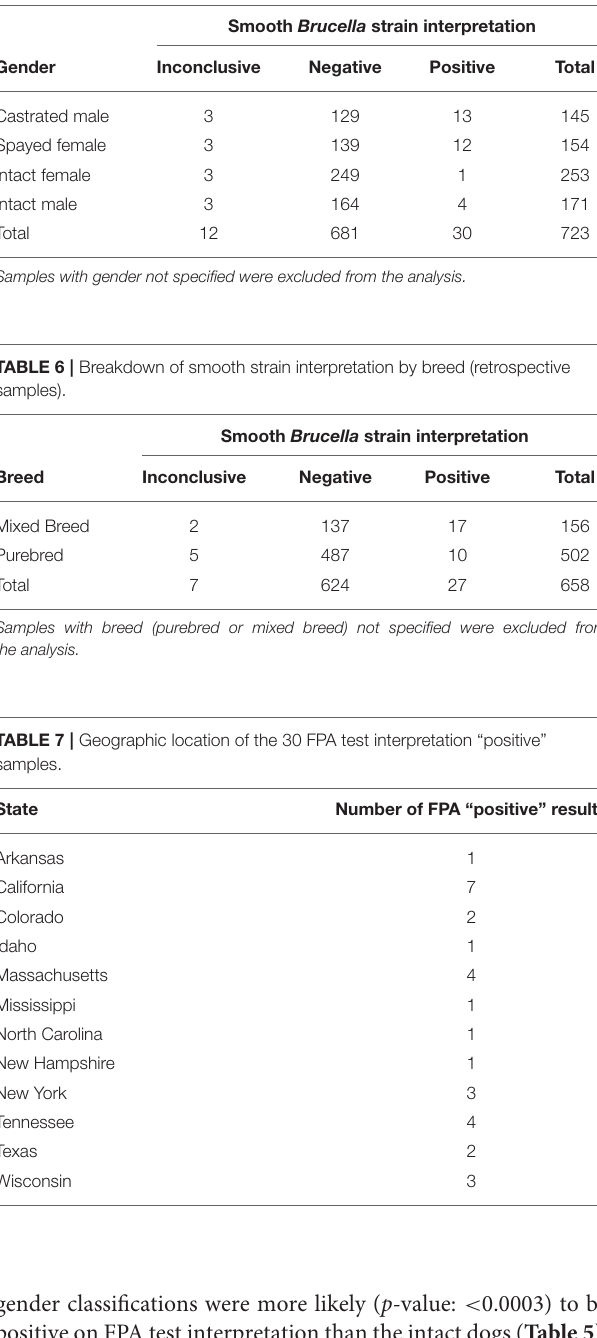
TABLE 5 | Breakdown of smooth strain interpretation by patient gender (retrospective samples).